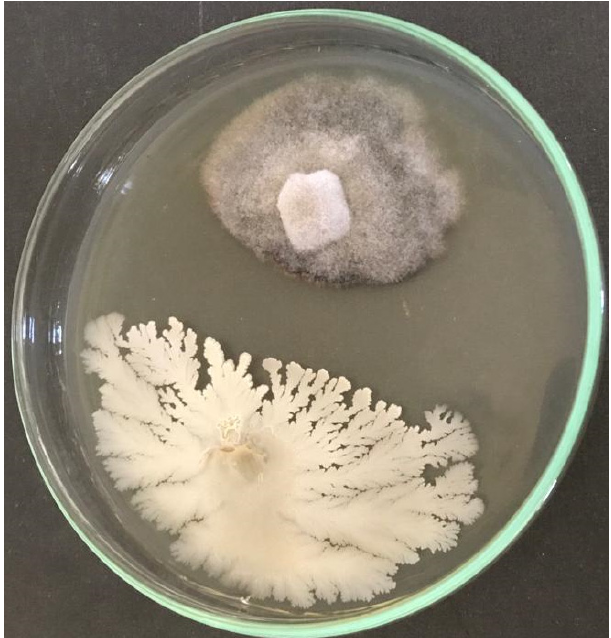
Figure 1. In vitro antifungal activity of Bacillus velezensis against Gaeumannomyces graminis var.